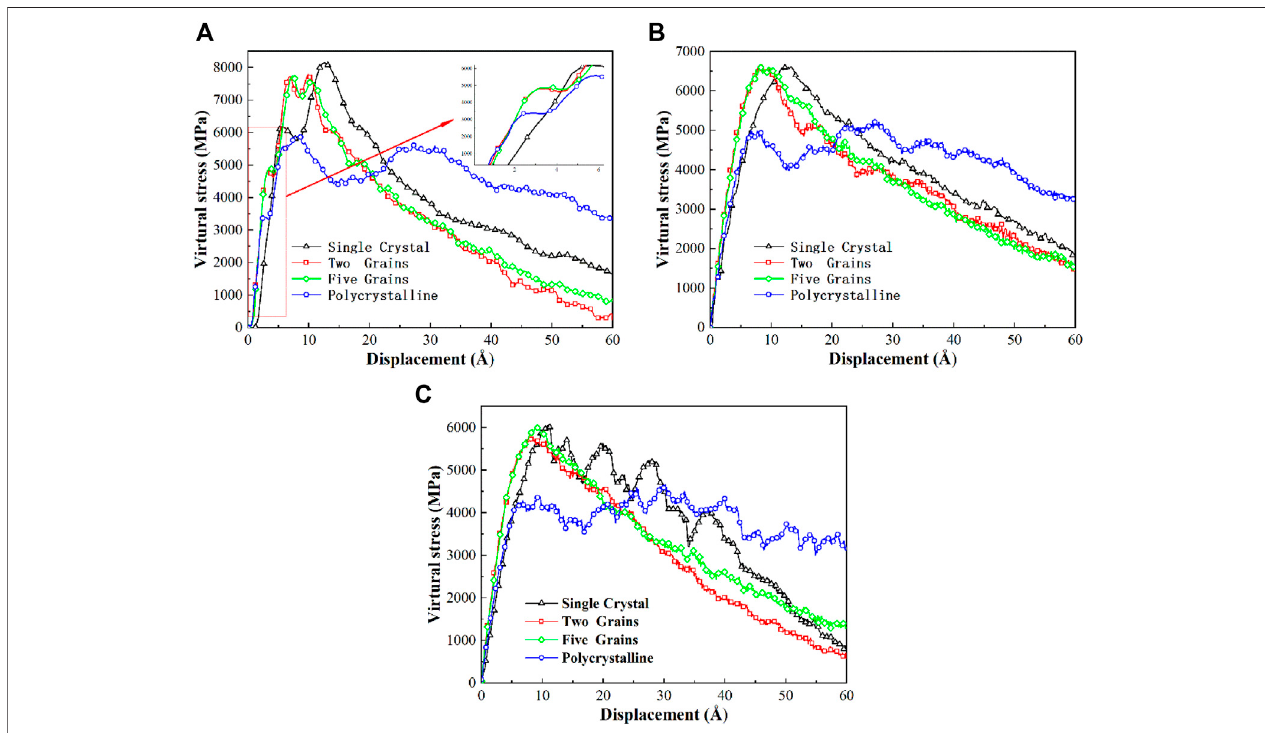
FIGURE 2 | Virial stress – displacement curves of the different models at strain rates of (A) 0.5% ps − 1 , (B) 0.1% ps − 1 , and (C) 0.01% ps − 1 .